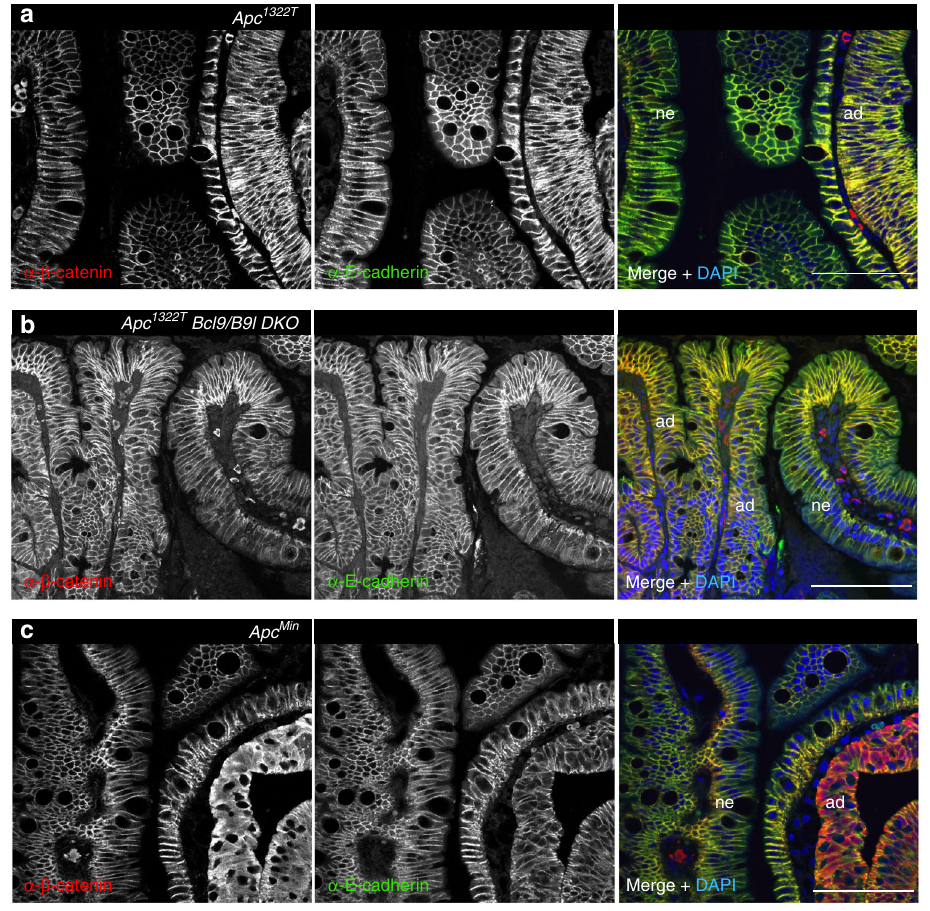
Fig. 7 The subcellular distribution of β -catenin in Apc 1332T adenoma cells is not sensitive to Bcl9 loss. IF of adenoma ( ad ) from ( a ) Apc 1332T , ( b ) Apc 1332T Bcl9/B9l DKO or Apc Min small intestines, and adjacent normal epithelia ( ne ), fi xed and stained as in Fig. 5; scale bars, 50 μ m. The nucleocytoplasmic β - catenin levels are barely elevated in Apc 1332T adenomas (compared to Apc Min adenoma, red fl uorescence in c ) and their cell surface β -catenin is high (yellow fl uorescence in a , b ) regardless of